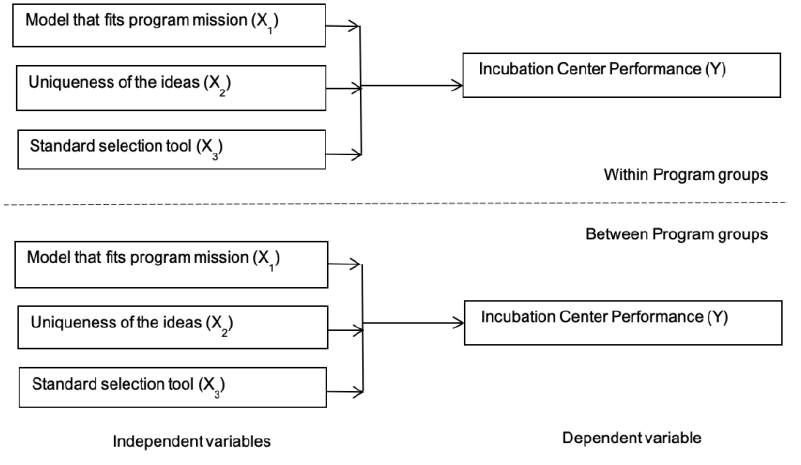
Figure 1 : Conceptual